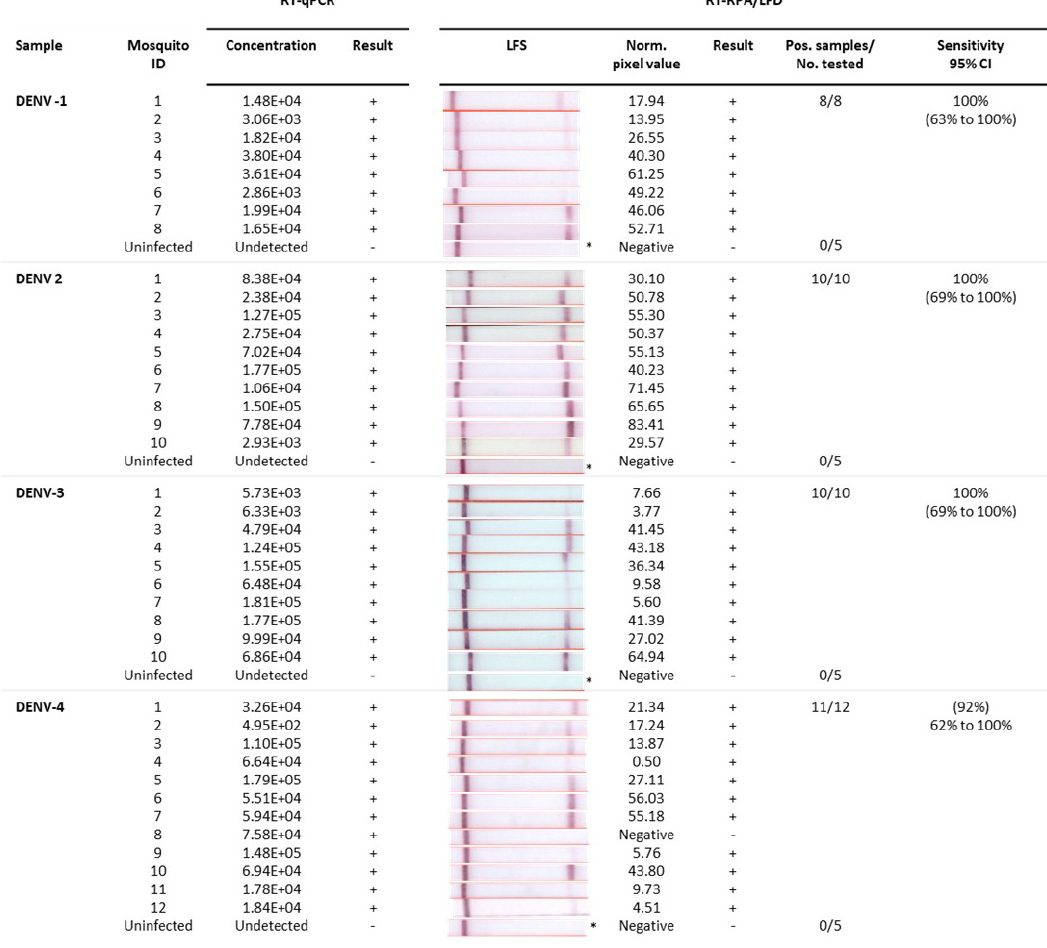
Figure 5. Detection of uninfected and infected individual mosquitoes by rapid dengue virus (DENV) 1–4 reverse-transcription recombinase polymerase amplification lateral flow detection (RT-RPA/LFD) assays and reverse-transcription quantitative polymerase chain reaction (RT-qPCR). Sample: Individual mosquitoes infected with DENV-1, DENV-2, DENV-3, DENV-4; Mosquito ID: Serotype-specific mosquito identification (ID) number; RT-qPCR: concentration (copies/µL) of each mosquito head extract tested and corresponding result (+/-); RT-RPA/LFD: Image of lateral flow strip (LFS) result from RT-RPA/LFD testing the corresponding mosquito body extract using the respective serotype RT-RPA/LFD test [Images of lateral flow strips with two bands (control and test band) indicates the sample is positive for respective DENV, and single control band indicates a valid reaction with negative sample]; Blank normalized (Norm.) black pixel value from the lateral flow strip and corresponding result (+/-); Number of mosquitoes that tested positive (Pos.) compared to the total number (No.) of mosquitoes tested with the respective DENV assay; and Sensitivity of the RT-RPA/LFD assay with 95% confidence interval (CI). *One representative lateral flow strip shown for uninfected mosquito